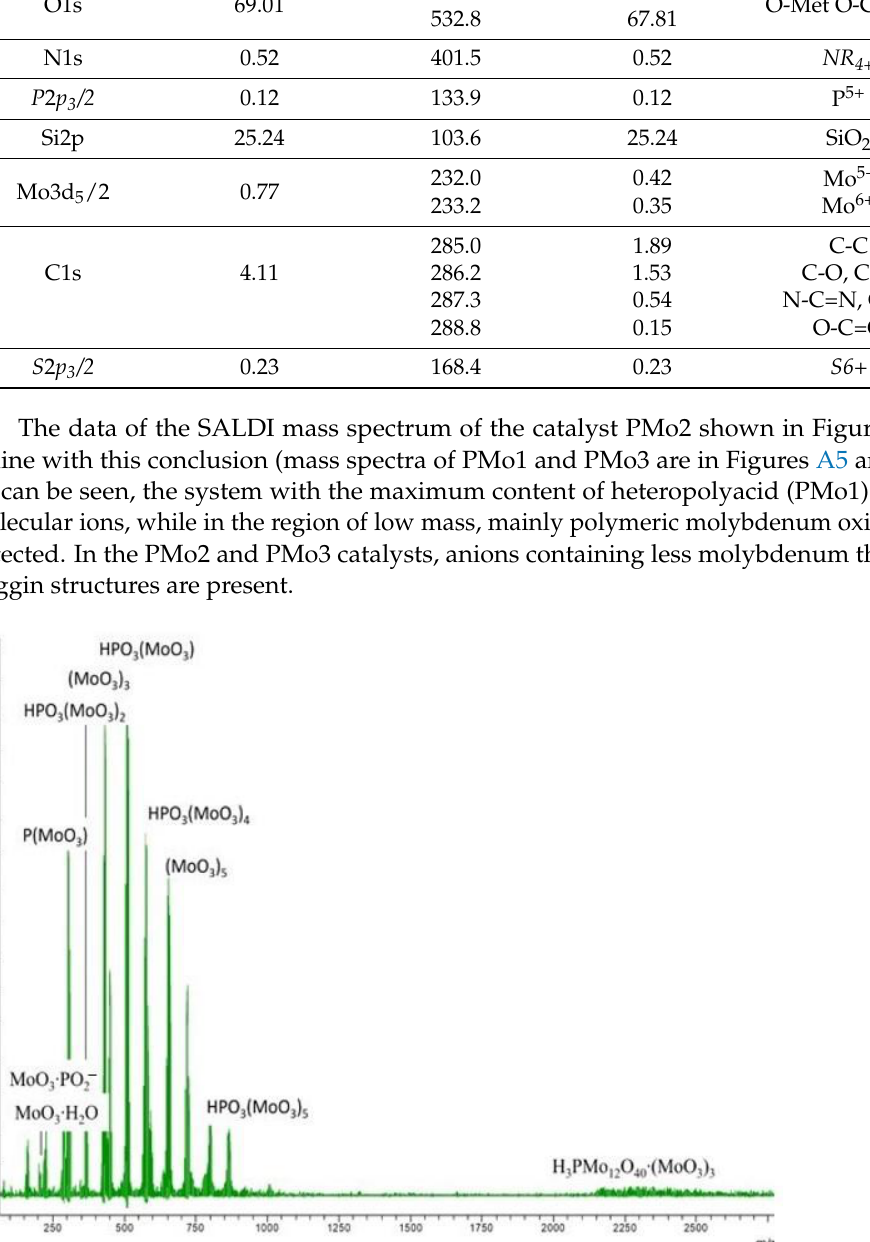
Table 4. Element concentrations, binding energies, and fractions of components in XPS spectra, and the corresponding types of bonds in the sample PMo2. Type of Content Binding Fraction, at.% Spectrum Chemical Bond Element, at. % Energies, eV 530.2 1.20 O1s 69.01 O-Met O-C, SiO 2 532.8 67.81 N1s 0.52 401.5 0.52